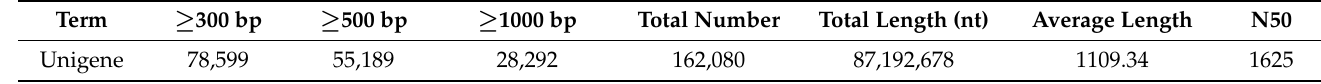
Table 2. Summary statistics of assembled gene sequences.